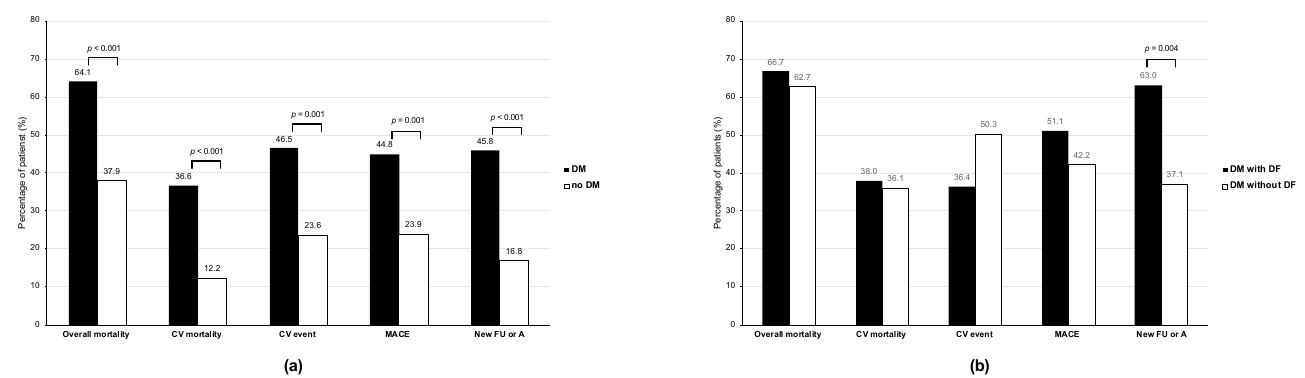
Figure 1. Percentage of patients on haemodialysis with studied clinical outcomes at 5-years of follow-up based on the presence of diabetes mellitus ( a ) and on the presence or absence of previous diabetic foot ( b ). CV, cardiovascular; DF, diabetic foot (ulcer or amputation); DM, diabetes mellitus; MACE, major adverse CV event.